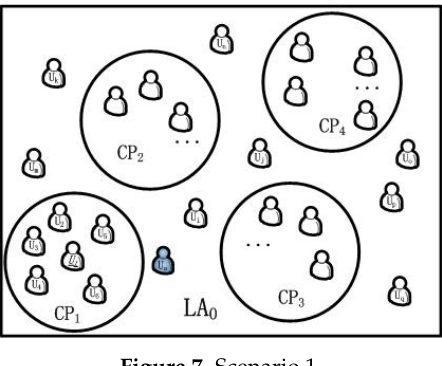
Figure 7. Scenario 1.